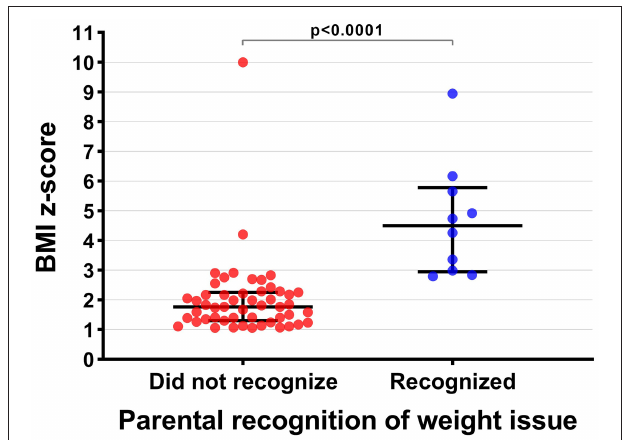
FIGURE 1 | Caregiver recognition of overweight in children with overweight or obesity and the children’s respective body mass index (BMI) z-scores ( n = 61). BMI z-scores were standardized for age and sex as per World Health Organization standards (24). Horizontal black bars represent the median and the interquartile range, while the p -value for the comparison between groups was derived from a t -test.